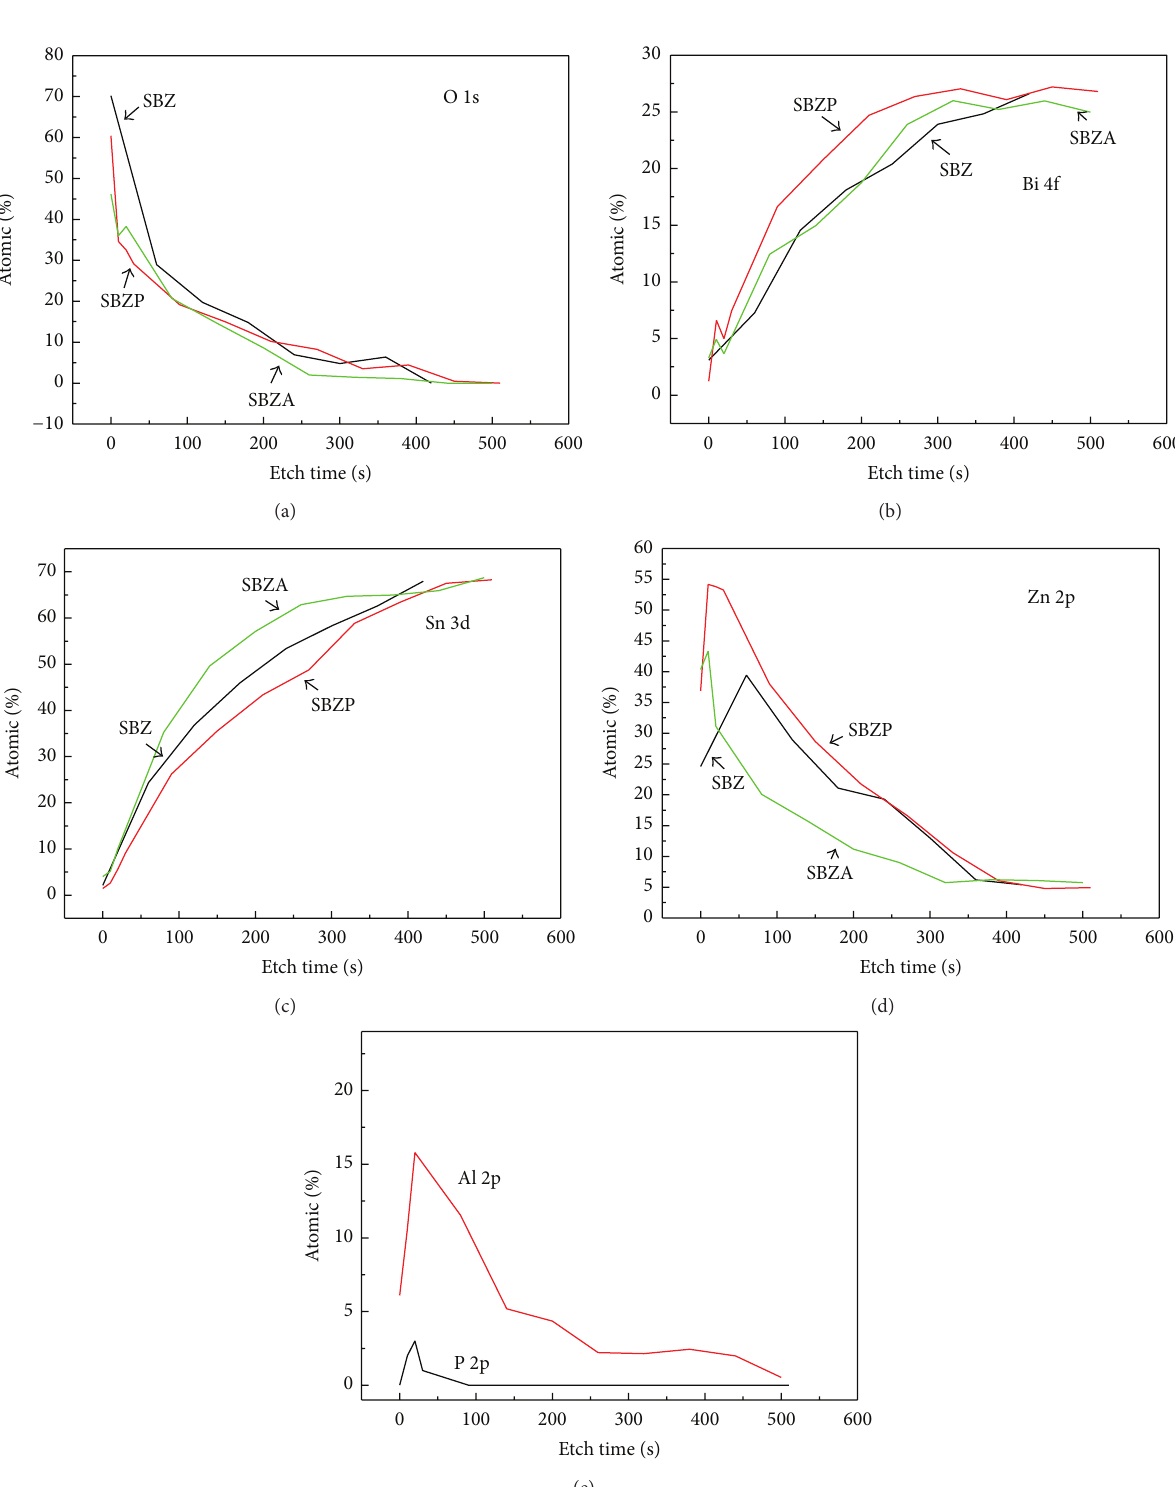
Figure 2: XPS depth profiles (at.%) for (a) oxygen, (b) zinc, (c) tin, (d) bismuth, and (e) aluminium and phosphorus recorded for the SBZ, SBZA, and SBZP